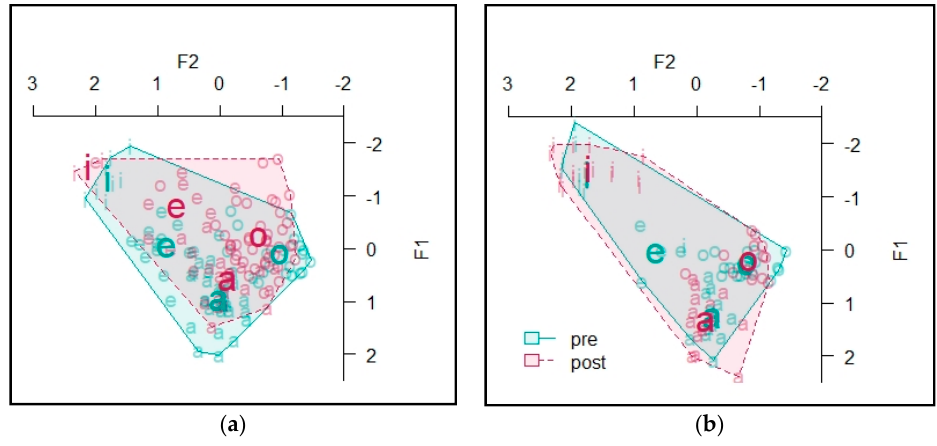
Figure 8. Informant B vowel spaces from pre-semester and post-semester measurements: ( a ) vowels from unstressed syllables; ( b ) vowels from stressed syllables.